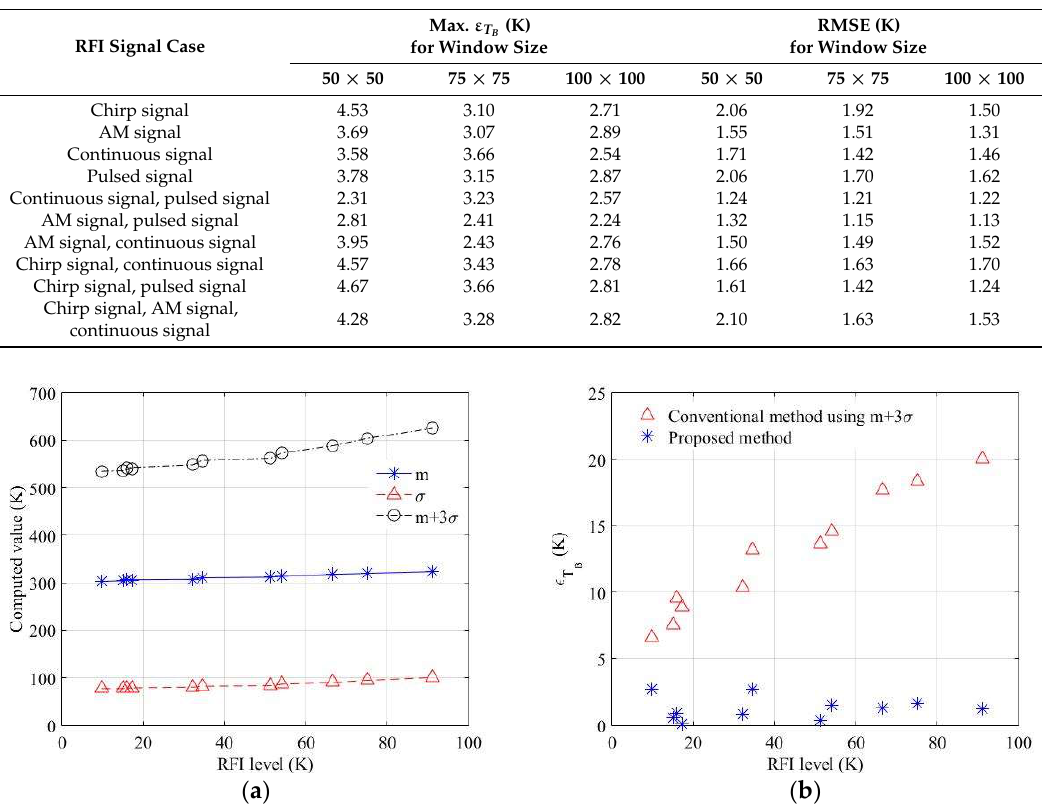
Figure 11. ( a ) Computed values from the bins in the brightness temperature spectrogram versus the level of chirp RFI signal occupied by the entire 1.407 to 1.411 GHz band; ( b ) error comparison of the conventional and proposed methods.